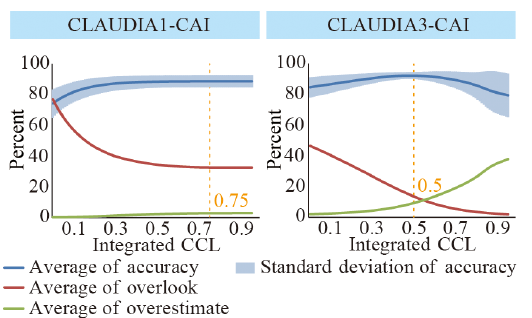
Figure 12. Average accuracy, overlook, and overestimate for all data for the Amazon. The most suitable integrated-CCL thresholds are 0.75 for CLAUDIA1–CAI and 0.5 for CLAUDIA3–CAI in the